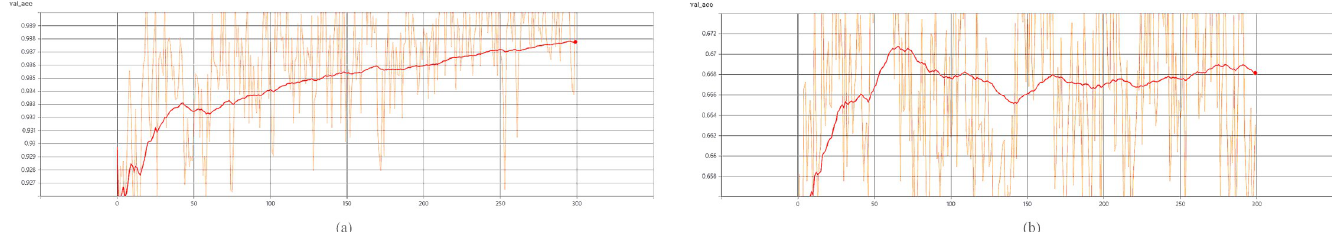
Fig 5. Loss during ResNet-50 training process for Electronic Home Applicants Design Award dataset. (Fig (a):Nominees classification accuracy; Fig(b): Eliminated classification accuracy).